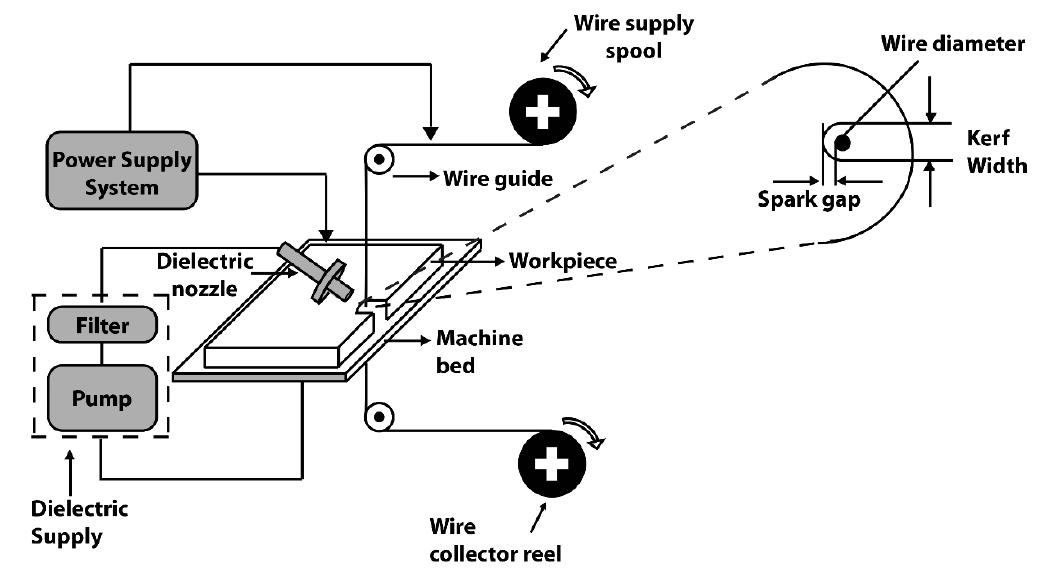
Figure 1. Schematic diagram of the wire electrode discharge machining (WEDM).